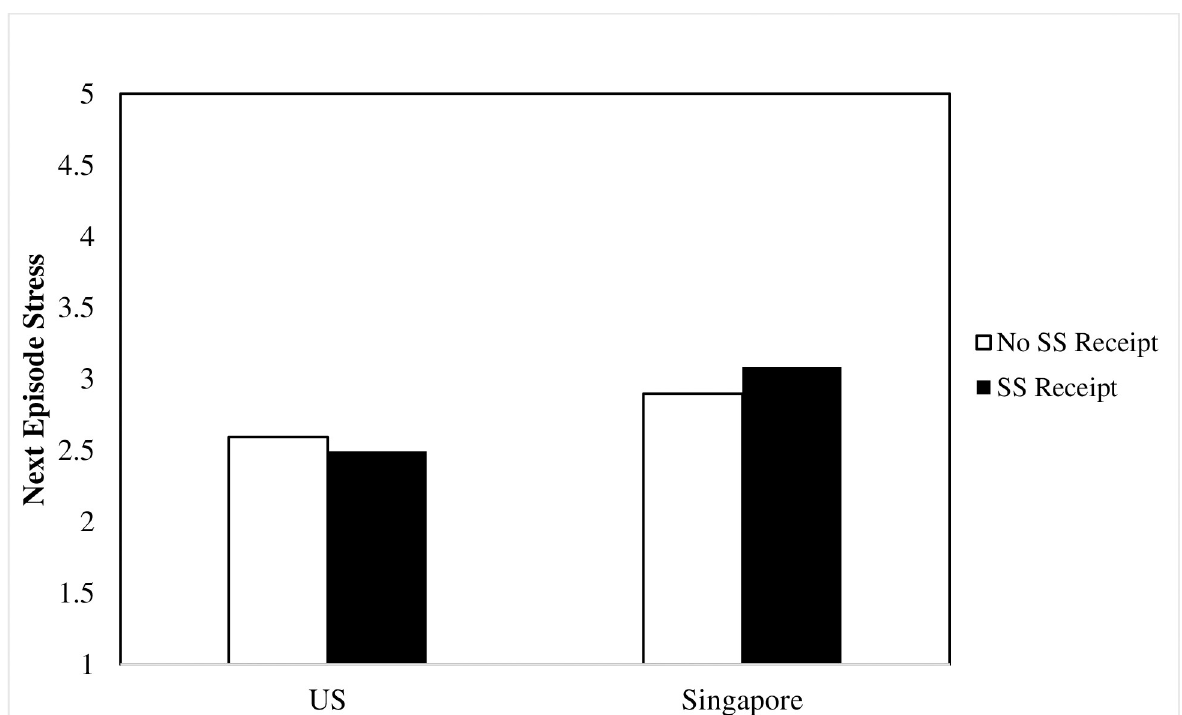
Fig 1. Interaction of culture and social support receipt on next episode